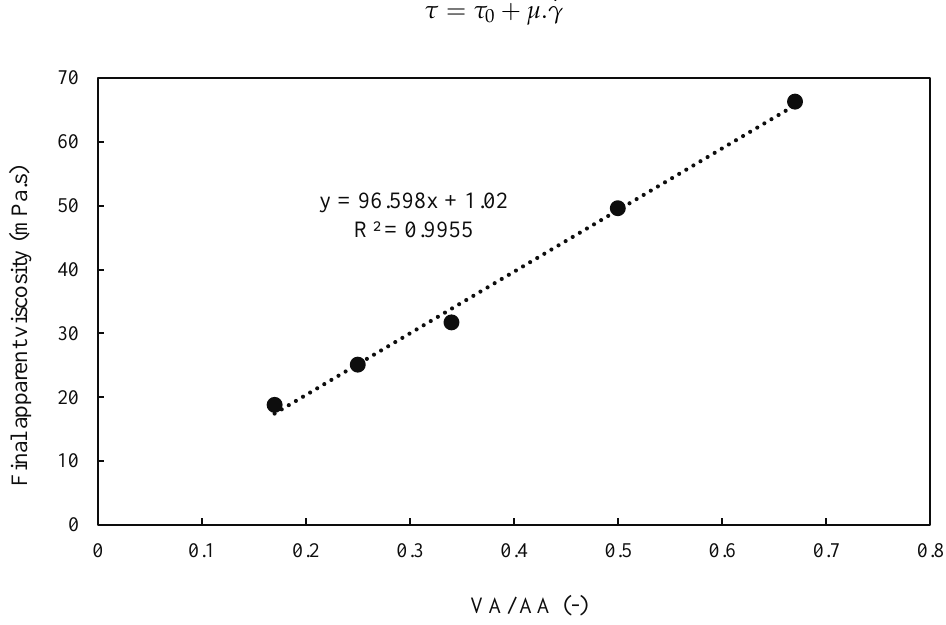
Figure 6. Relationship between final apparent viscosity and ratio of volcanic ash to alkaline activator. Table 4. Rheological parameters of geopolymeric pastes with different binder-to-activator ratios.